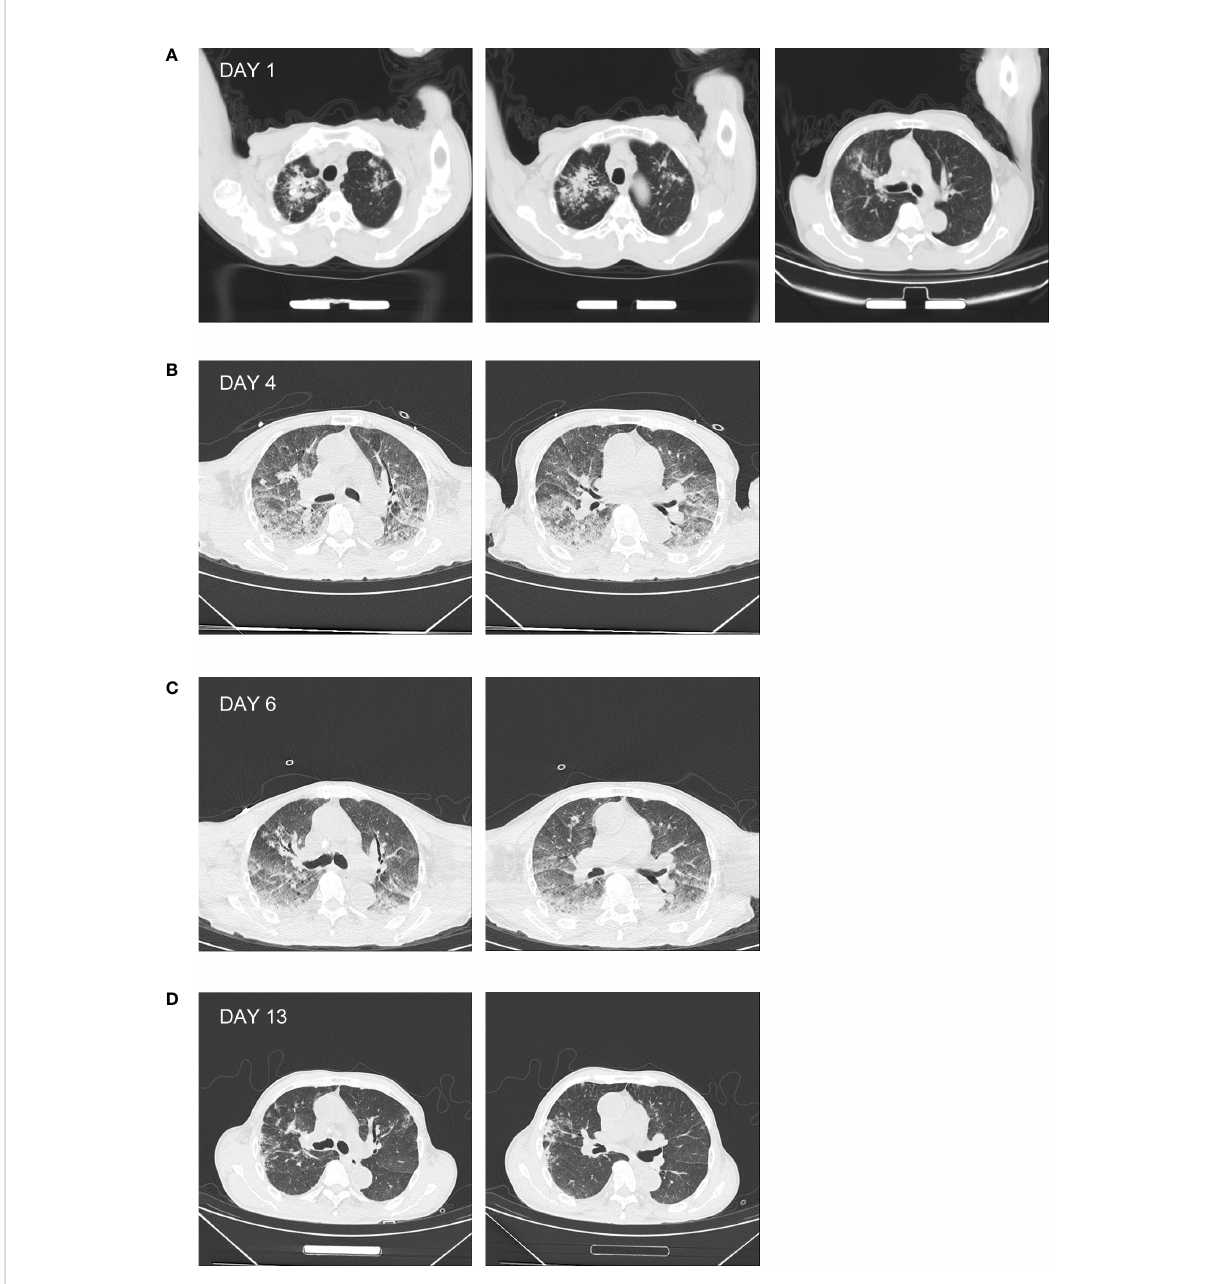
FIGURE 1 Chest CT of the patient. (A) The chest CT prior to admission showing high-density patchy and streak-like shadows in the lung, with unclear margin. (B) The chest CT of day 4 showing enhanced patchy and nodular high-density shadows in the lung, associated with diffused ground- glass opacities. (C) The chest CT of day 6 showing the relief of the patchy high-density shadow. (D) The chest CT of day 13 showing the absorption of the patchy high-density